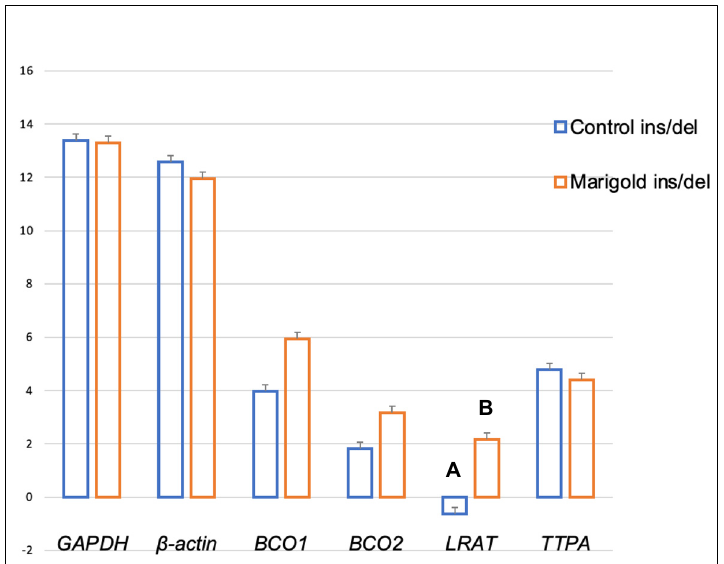
Figure 7. Relative BCO1 , BCO2 , LRAT, and TTPA mRNA levels (log2 abundance) in the brain of rabbits with the ins/del genotype at codon 248 of the BCO2 gene, fed different diets (control diet vs. a diet with the addition of Aztec marigold flower extract). GAPDH and ß-actin were used as reference genes. Data represent posterior means (expressed as arbitrary units) ± SEM (standard error of the mean). Means followed by the different superscripts (A, B) differ highly significantly ( p ≤ 0.01).